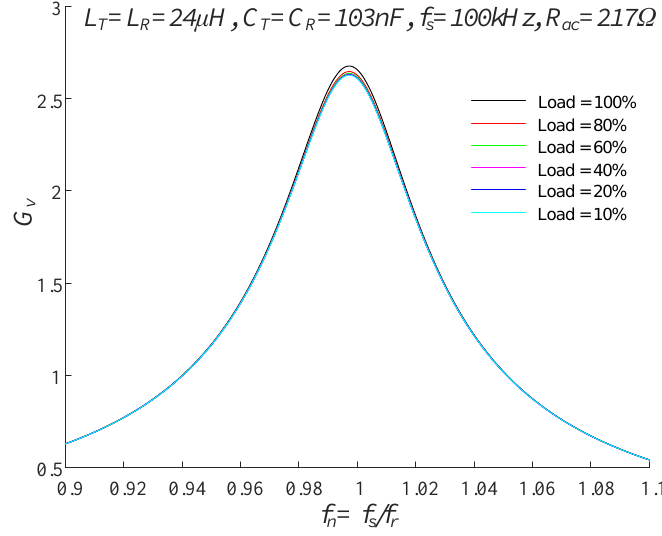
Figure 5. Voltage conversion ratio according to load variation.